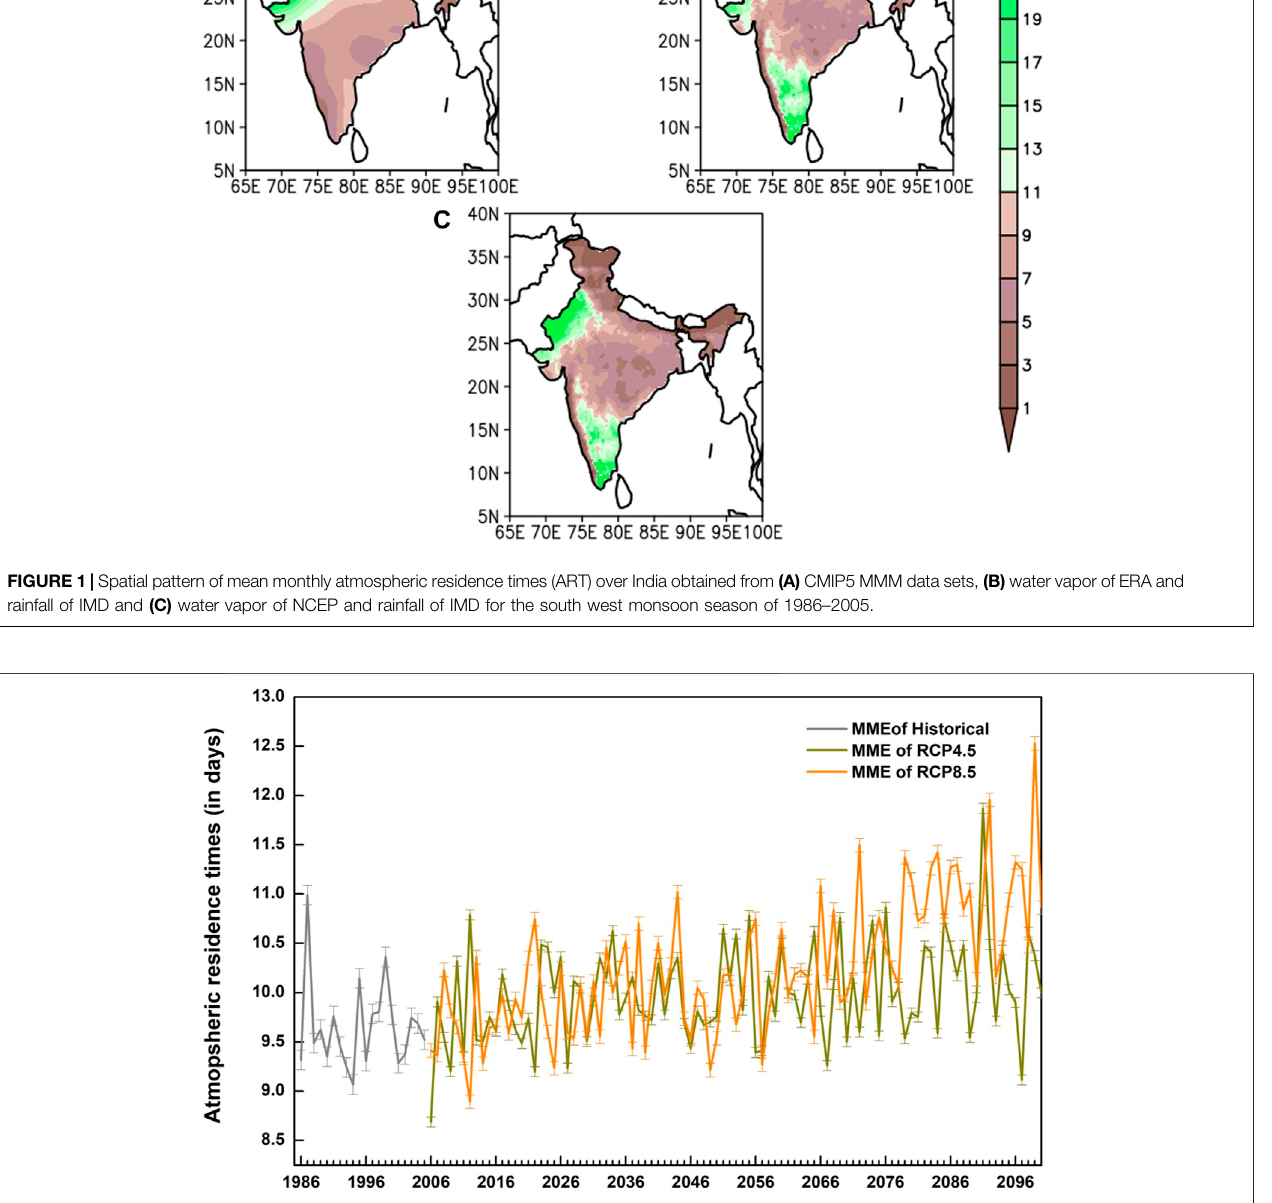
Frontiers in Earth Science |